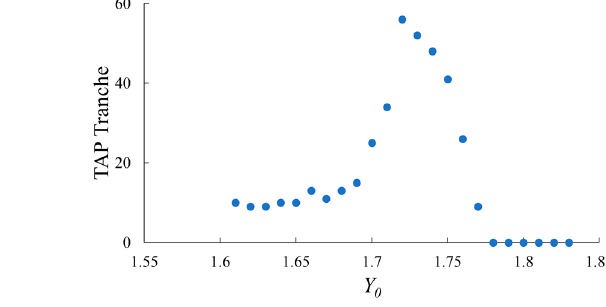
Figure 6. Schematic of LEs vs Y graphed over the domains of AVI at different values of the gain, C . ( a – e ) C = 3.0 , 3.2 , 3.25 , 3.3 , and 3.35, respectively.